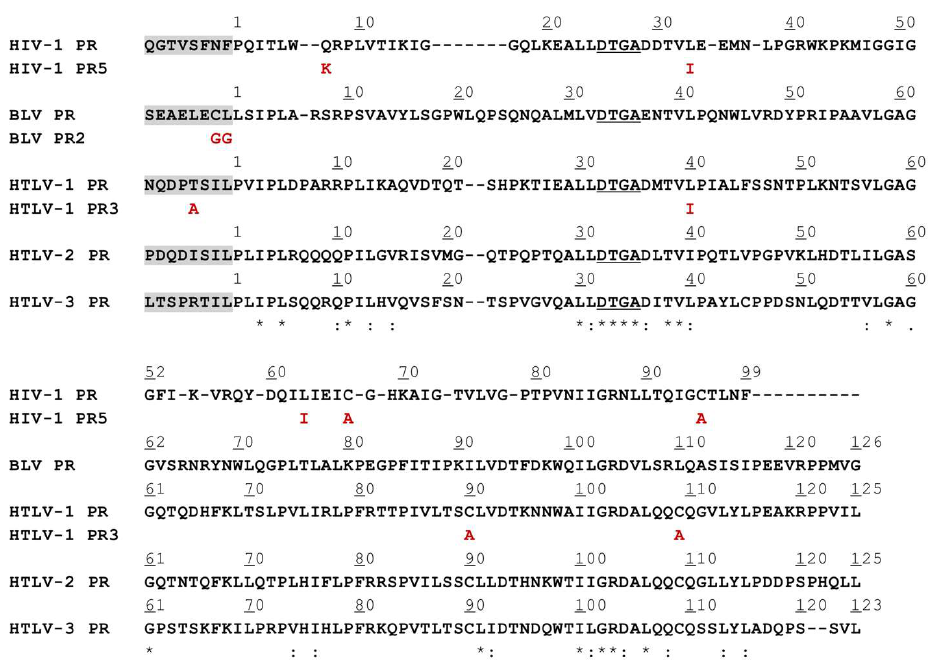
Figure 1. Sequence alignment of HIV-1, BLV, and HTLV proteases. The aligned sequences of HIV-1, BLV, and HTLV proteases are shown. The grey background highlights the N-terminal flanking sequences between the MBP and the protease, these linkers represent the P8-P1 residues of the N-terminal autoproteolytic cleavage site sequences of the corresponding proteases. The residues of the consensus catalytic motif are underlined, the residues that are modified in the fusion proteins are shown by red. Asterisks indicate identical residues.